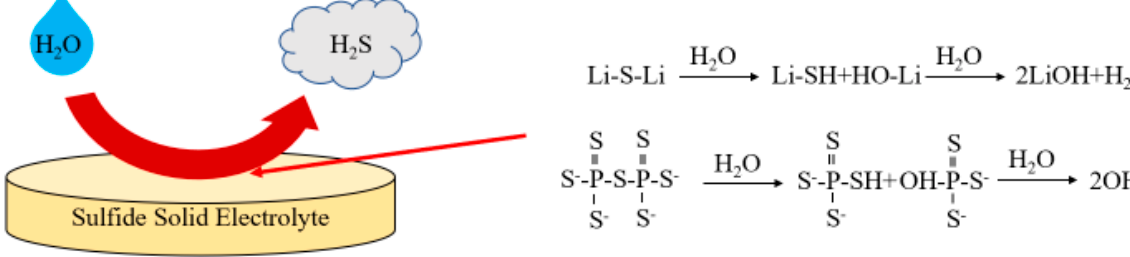
Figure 9. Instability of sulfide electrolytes in moist air and corresponding reactions. Zhang et al. reported the solid solutions of Li 4–x Sb x Sn 1–x S 4 with 0 ≤ x ≤ 0.5 [168]. Li 3.8 Sb 0.2 Sn 0.8 S 4 shows the highest ionic conductivity of 3.5 × 10 − 4 S · cm − 1 among the system and high stability in moist air due to the high affinity of Sn-S and Sb-S. Liang et al. doped Sb 5+ into LGPS as Sb 5+ can form stronger covalent bonds with S 2 − than P 5+ [169]. The Li 10 Ge(P 1–x Sb x ) 2 S 12 ionic conductors exhibit high air stability and have a high conduc- tivity of 12.1~15.7 × 10 − 3 S · cm − 1 even after being exposed to humid environment. The partial substitution of O 2 − for S 2 − in the structure can not only maintain the replaced Li 2 S with Li 2 O in the 75Li 2 S · 25P 2 S 5 glass. The (75-x)Li 2 S · 25P 2 S 5 · xLi 2 O could